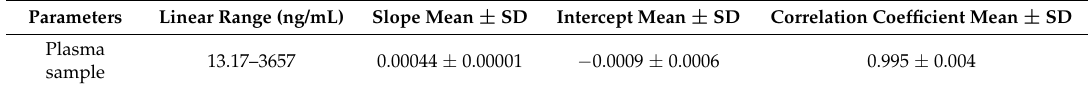
Table 1. Calibration curve parameters ( n = 9).